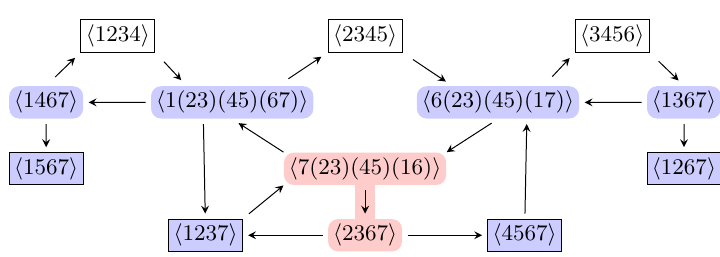
Figure 24. A cluster corresponding to the 6 th term in A 7 ; 2